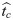
Predicted critical end time tc^ as the function of dt for the four historical bubbles.(A) S&P 500 1987 bubble. (B) S&P 500 2007 bubble. (C) SSEC 2007 bubble. (D) SZSC 2009 bubble. Each panel shows the medians (red stars) and averages (black squares) of tc^ as functions of dt for the fixed tend given in Table 1, over the population of q values spanning {q = 0.01, 0.02, …, 0.99}. The blue triangles are L2 calibration based predictions for comparation. For each panel, the black dashed line shows the respective position of tend, and the red dashed line shows the corresponding true critical date Tc.